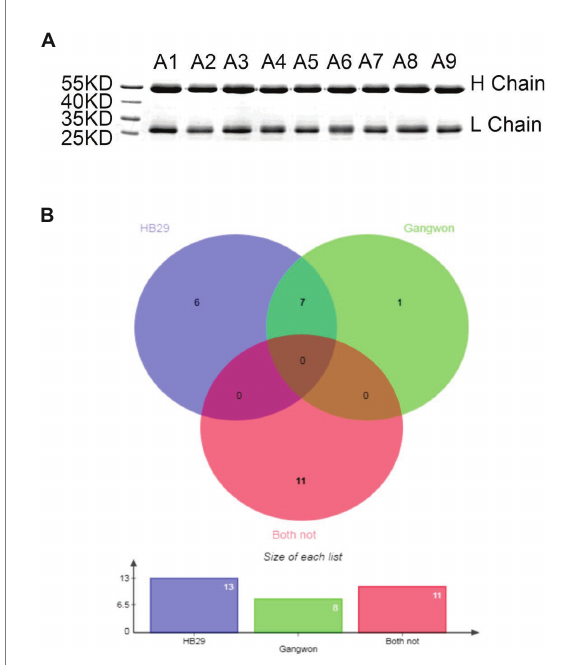
FIGURE 4 The neutralizing activity of IgG from 25 different patients against pseudovirus of HB29 and Gangwon. (A) IgG purified from sera of convalescent by SDS-PAGE. The molecular weight of the heavy chain is 50 KD, and the Light chain is over 25 KD. The purity is over 95%. (B) Venn diagram shows 25 nAbs that neutralized pseudovirus HB29 and Gangwon strain analyzed using online software. Violet blue highlights 13 nAbs that neutralized HB29 pseudovirus, green highlights eight nAbs that neutralized Gangwon pseudovirus, and red highlights 11 nAbs that neutralized neither HB29 pseudovirus nor Gangwon pseudovirus. There are seven nAbs that neutralized both HB29 and Gangwon pseudovirus.